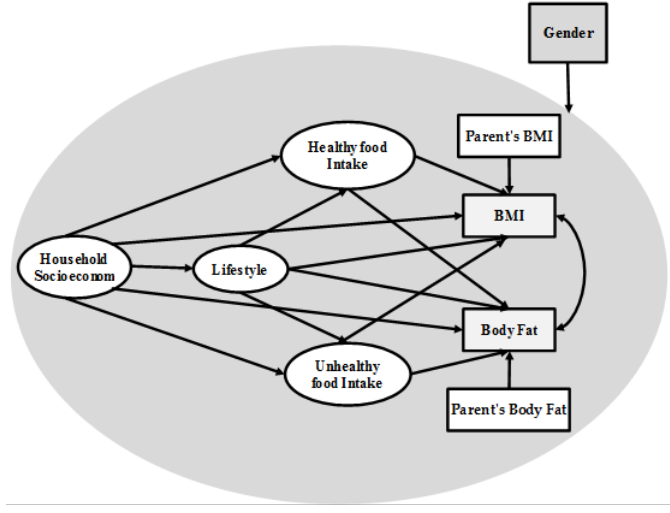
Figure 1. Research framework.